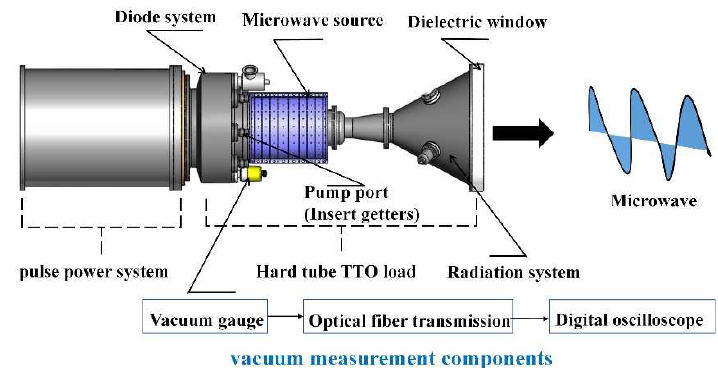
Figure 6. Schematic illustration of the experimental setup.